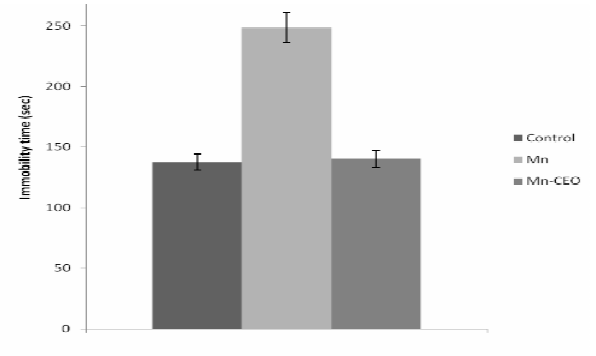
Fig.2. Effect of Mn exposure and clove essential oil during pregnancy and lactation period on depression. Data are mean ± S.E.M. *** p <0.001. (Mn vs Control) p <0.001; (Mn vs Mn- CEO) p